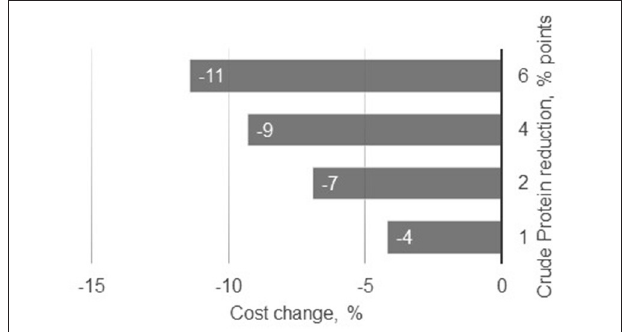
FIGURE 2 | Changes in estimated feeding costs as result of changes in crude protein content in the